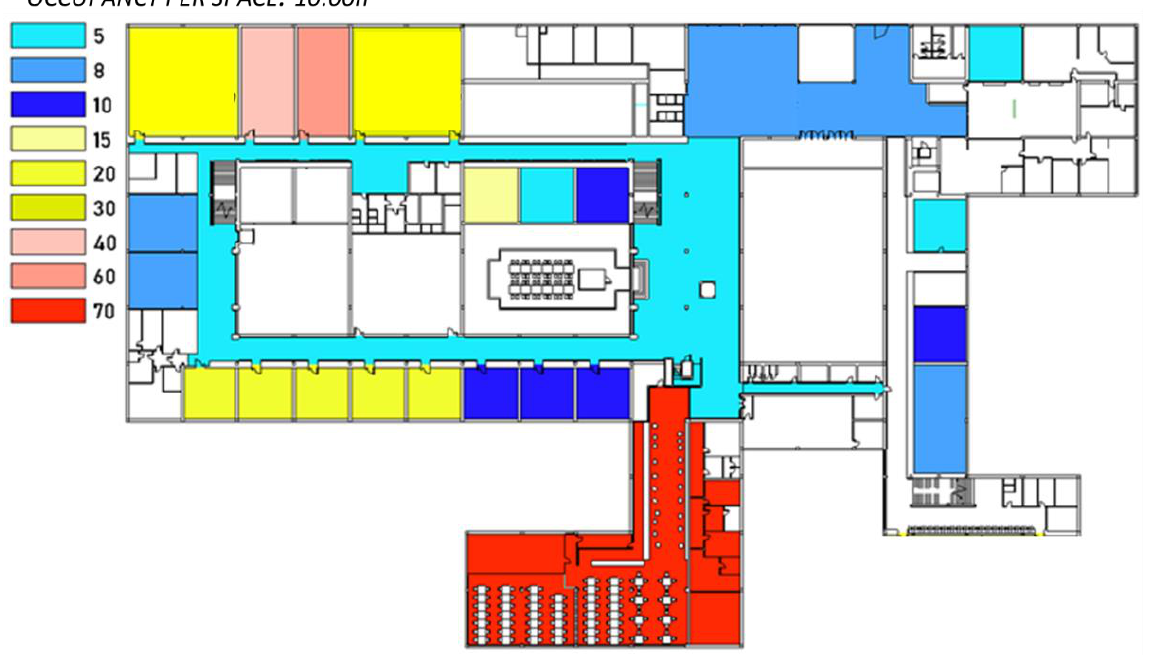
Figure 6. BIM model data output by real time occupation.